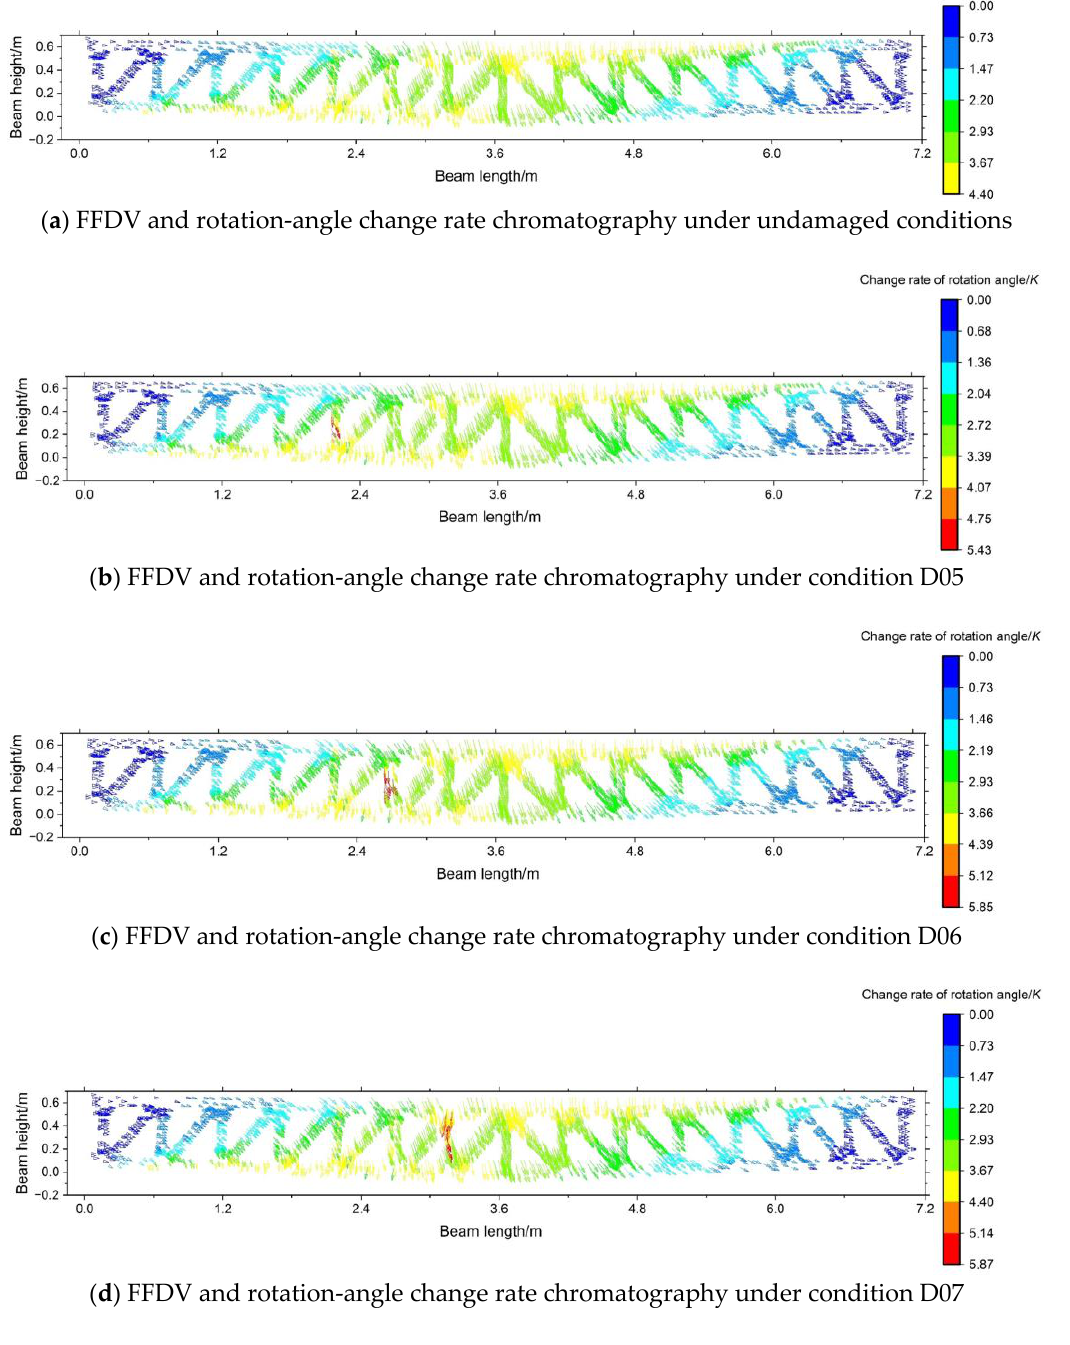
Figure 35. Diagram of FFDV and rotation-angle change rate chromatography.